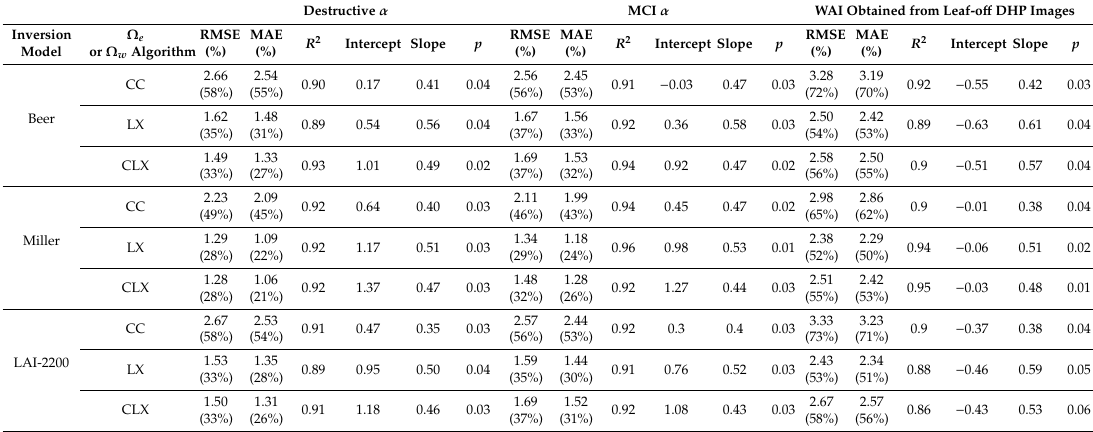
Table 5. Correlation statistics between the litter collection LAI and the LAI derived from the leaf-on DHP images using the three canopy element or woody components clumping index ( Ω e or Ω w ) algorithms, three inversion models, and destructive or MCI woody-to-total area ratio ( α ) or WAI obtained from the leaf-o ff DHP images in the five plots (two-tailed Student’s t -test with 95% confidence level). The root mean square error (RMSE) and mean absolute error (MAE) are expressed in LAI units (m 2 / m 2 ). Destructive α MCI α WAIObtainedfromLeaf-o ff DHPImages Inversion